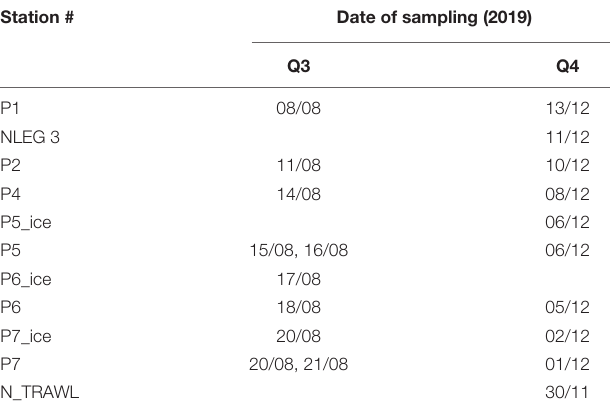
TABLE 1 | Station information for RV Kronprins Haakon seasonal Nansen Legacy cruises Q3 during August 2019 and Q4 during November/December 2019 in the Barents